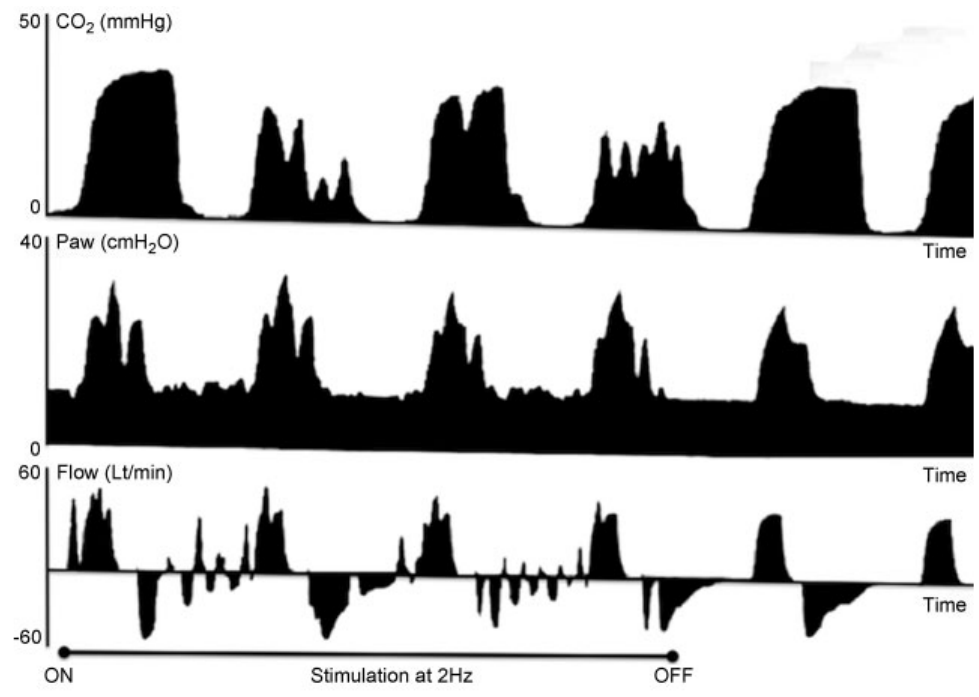
Fig. 1 Intraoperativestimulationofphrenicnerveat1 mAand2 Hzinapatientoperatedforupperbrachialplexustrunktumor(schwannoma).Combined studyofthethreecurves:(1)Theonsetandendofchangesonpressureand fl owcurvesareconcomitantwiththeonset(ON)andend(OFF)ofstimulationon pressureand fl owcurves.Capnography lagsbehindby afewseconds.(2) Sharpnonspeci fi c descendsoncapnography. Successivedentationsonpressure – timeandminiaturerespiratorycycleson fl ow – timecurves,compatiblewithrepetitivepartialcontractionsofthediaphragm.(3)Thecalculationoffrequency iseasierduringexpirationandmaynecessitatefreezingthescreenforafewseconds.Inourexample,ventilatorfrequency ¼